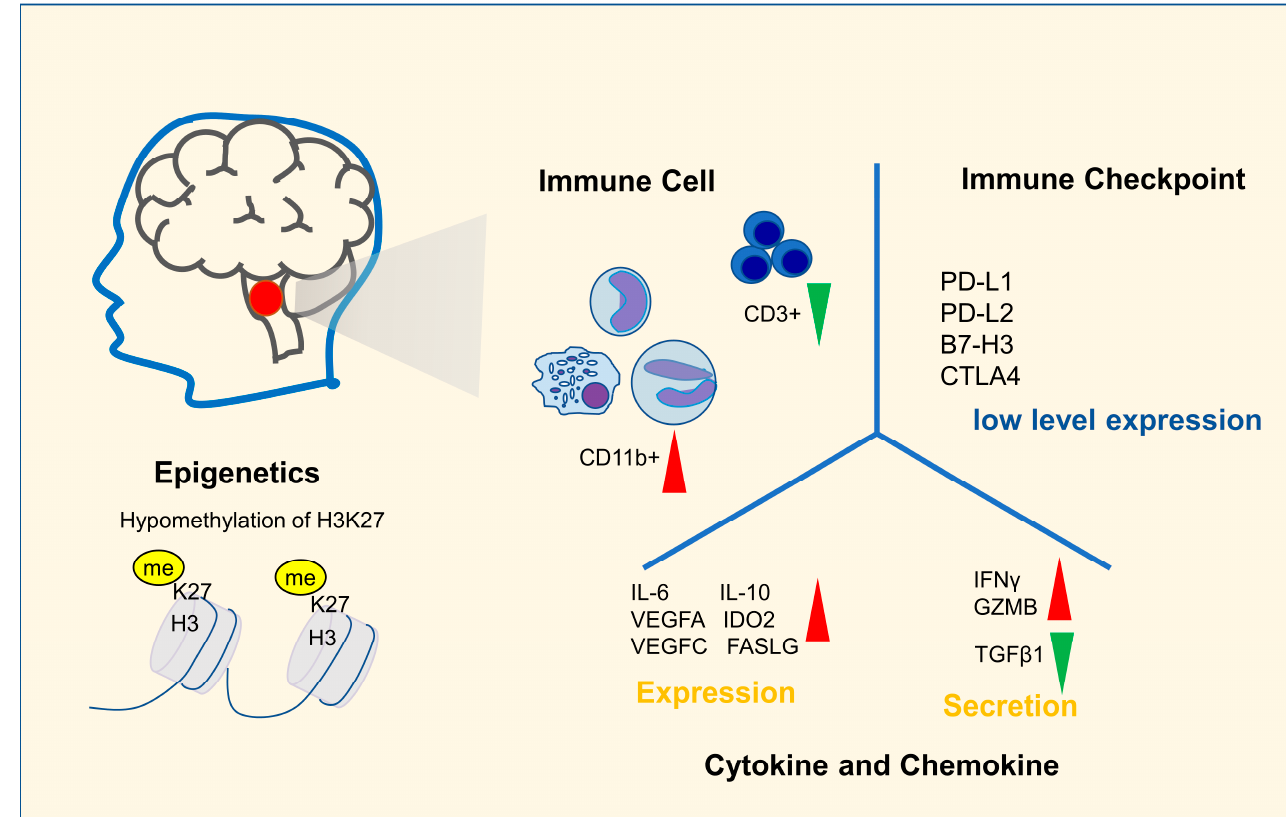
Figure 1. The epigenetic and immune microenvironment characteristics of DIPG. Most DIPGs have hypomethylation of H3K27. Compared with other high-grade gliomas, DIPG has lower CD3 + T cell infiltration and a higher proportion of CD11b + cell infiltration in its immune microenvironment. There is little expression of inhibitory immune checkpoints in DIPG, the expression of immunosuppressive cytokines is relatively low and the expression of proinflammatory factors is relatively high compared with high grade glioma.